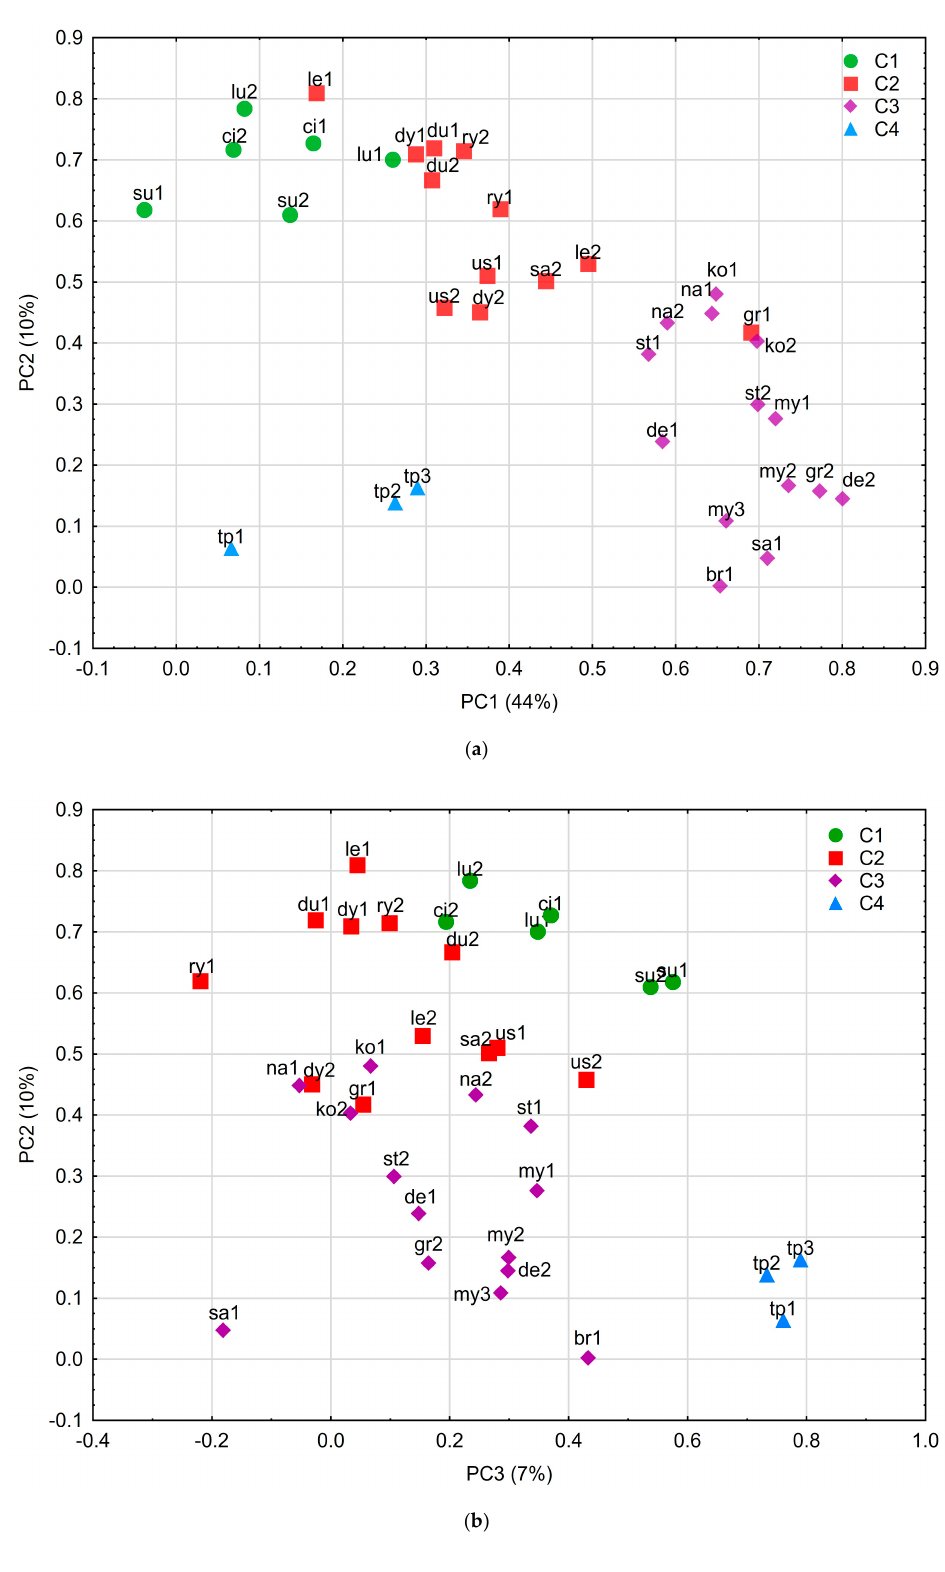
Figure 4. Scatterplot of the PCA results (after Varimax rotation). Sites and clusters (C1–C4) are marked. ( a ) PC1 vs. PC2; ( b ) PC2 vs. PC3.